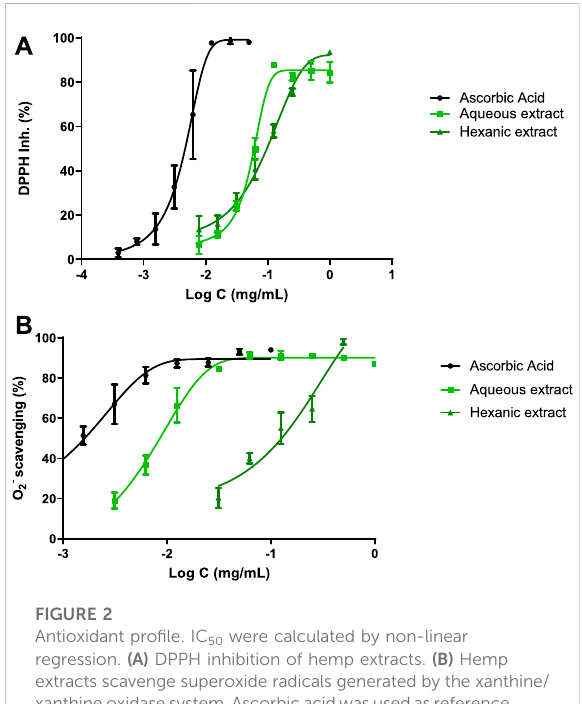
Antioxidant pro fi le. IC 50 were calculated by non-linear regression. (A) DPPH inhibition of hemp extracts. (B) Hemp extracts scavenge superoxide radicals generated by the xanthine/ xanthineoxidasesystem.Ascorbicacidwasusedasreference